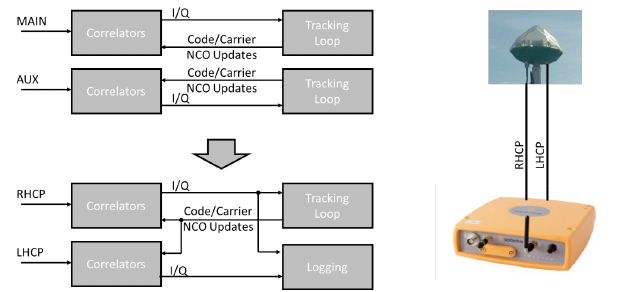
Figure 4. Software modifications included in the AsteRx-U receiver.